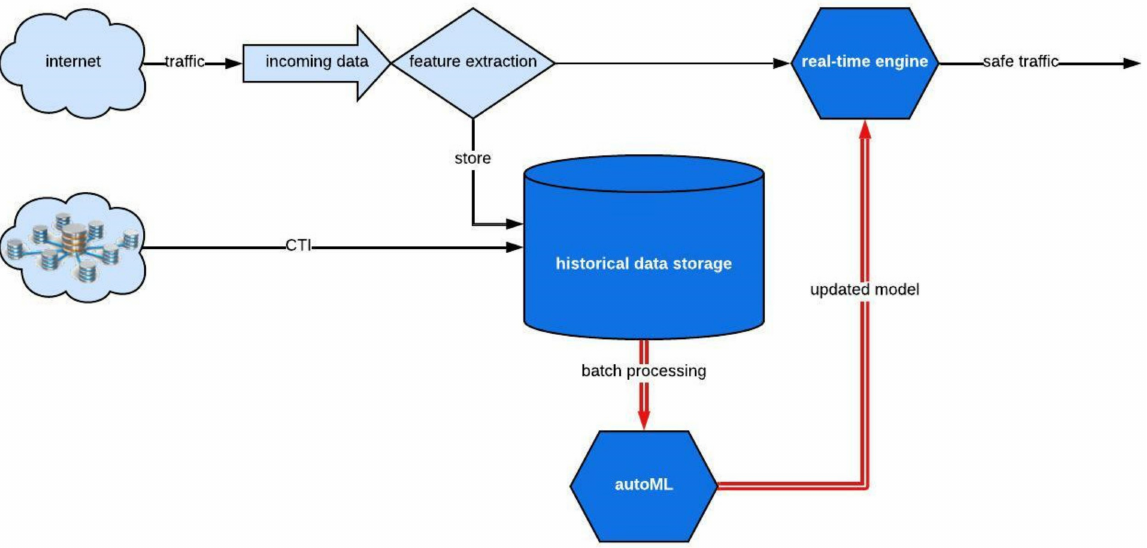
Figure 2. The proposed Architecture (the main core of ANTA and BANTA systems) which is based on the Lambda